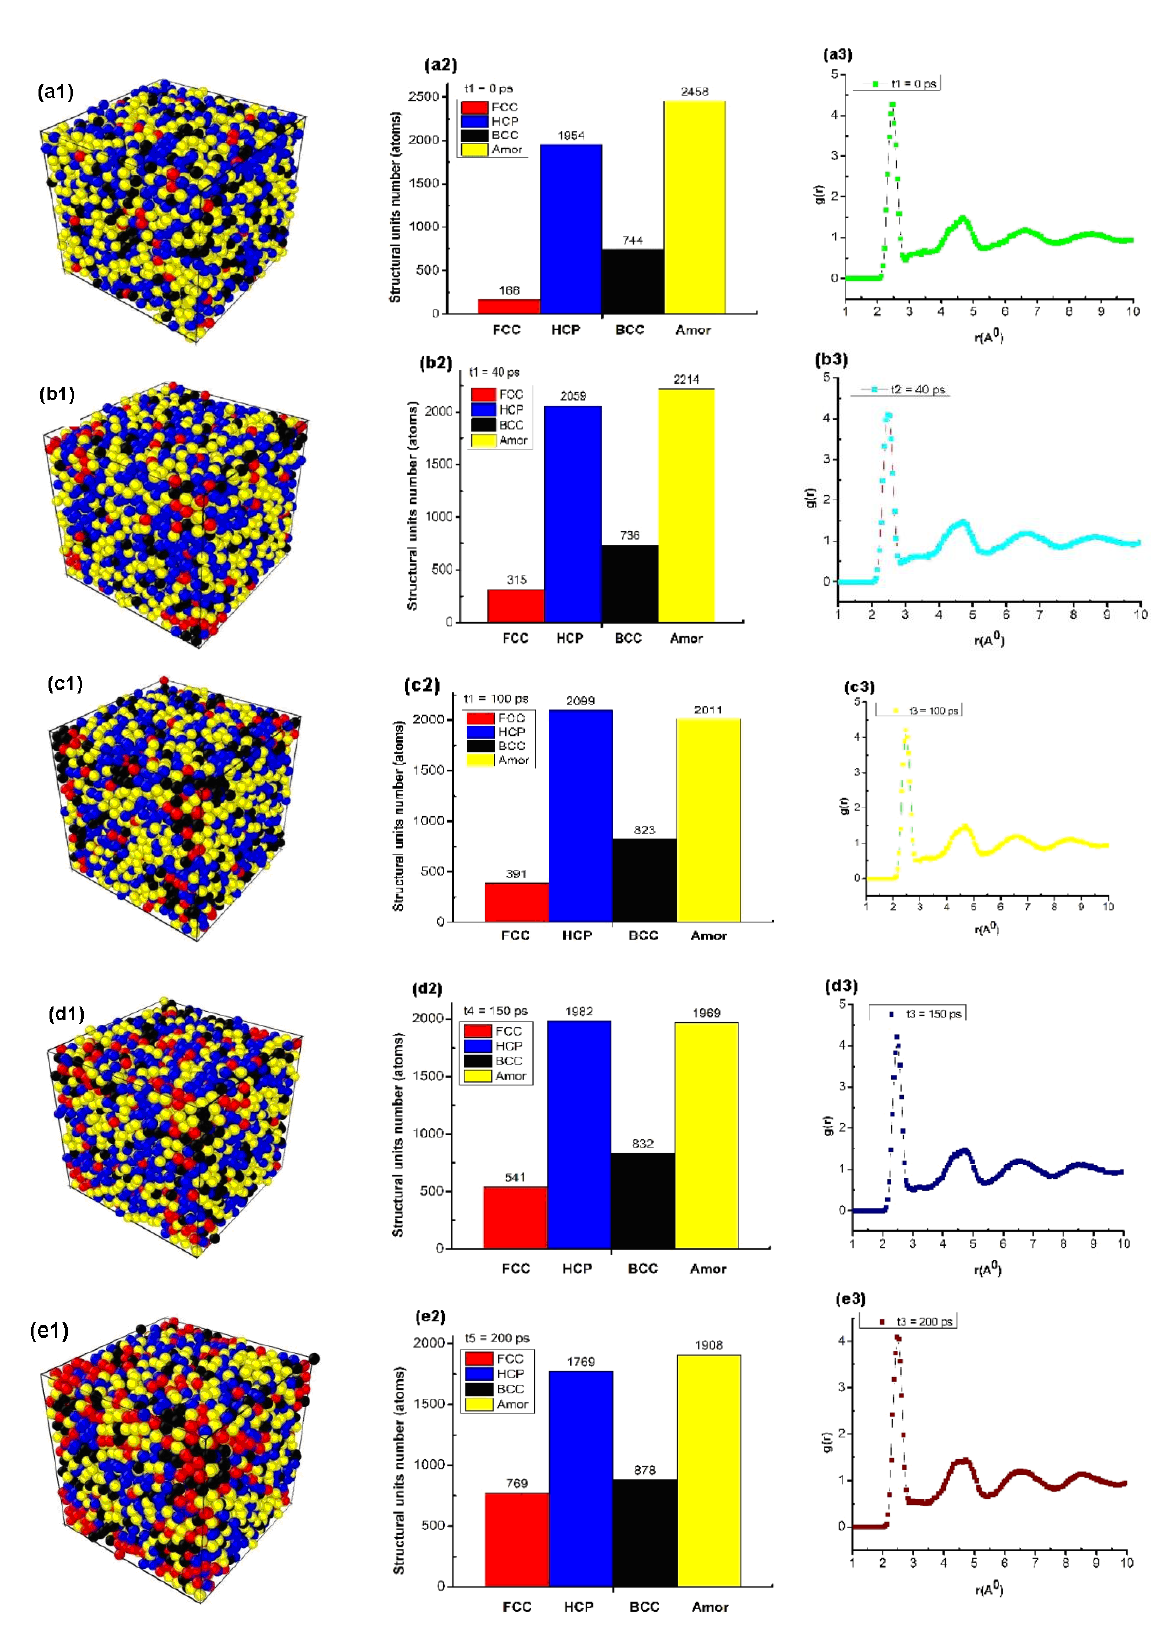
Figure 6. Structural characteristic quantities, such as: structure shape ( a1 , b1 , c1 , d1 , e1 ), number of structural units ( a2 , b2 , c2 , d2 , e2 ), and radial distribution function ( a3 , b3 , c3 , d3 , e3 ) of bulk Cu 5324 material with different annealing times .